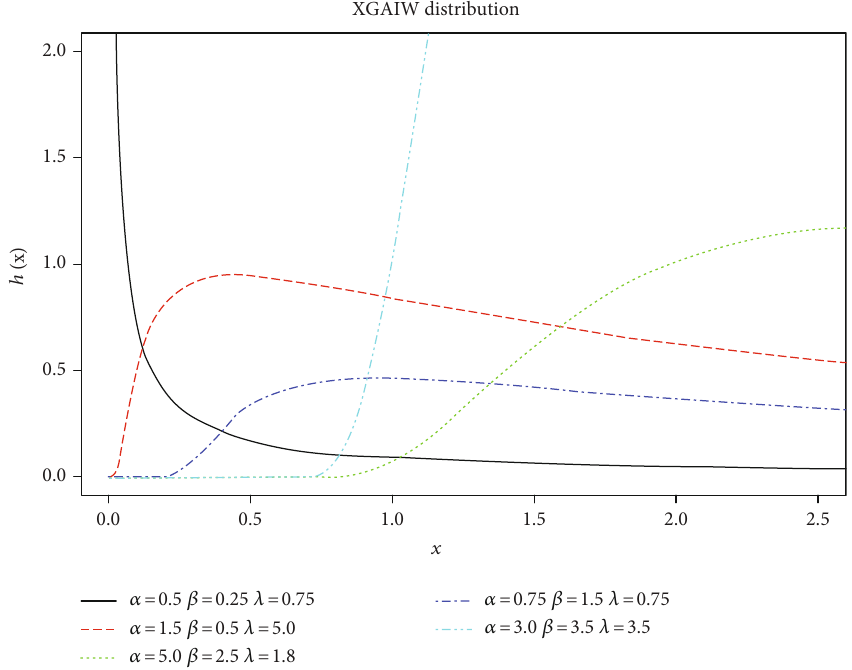
Figure 2: Plots of the HRF of the XGAIW distribution for di ff erent values of